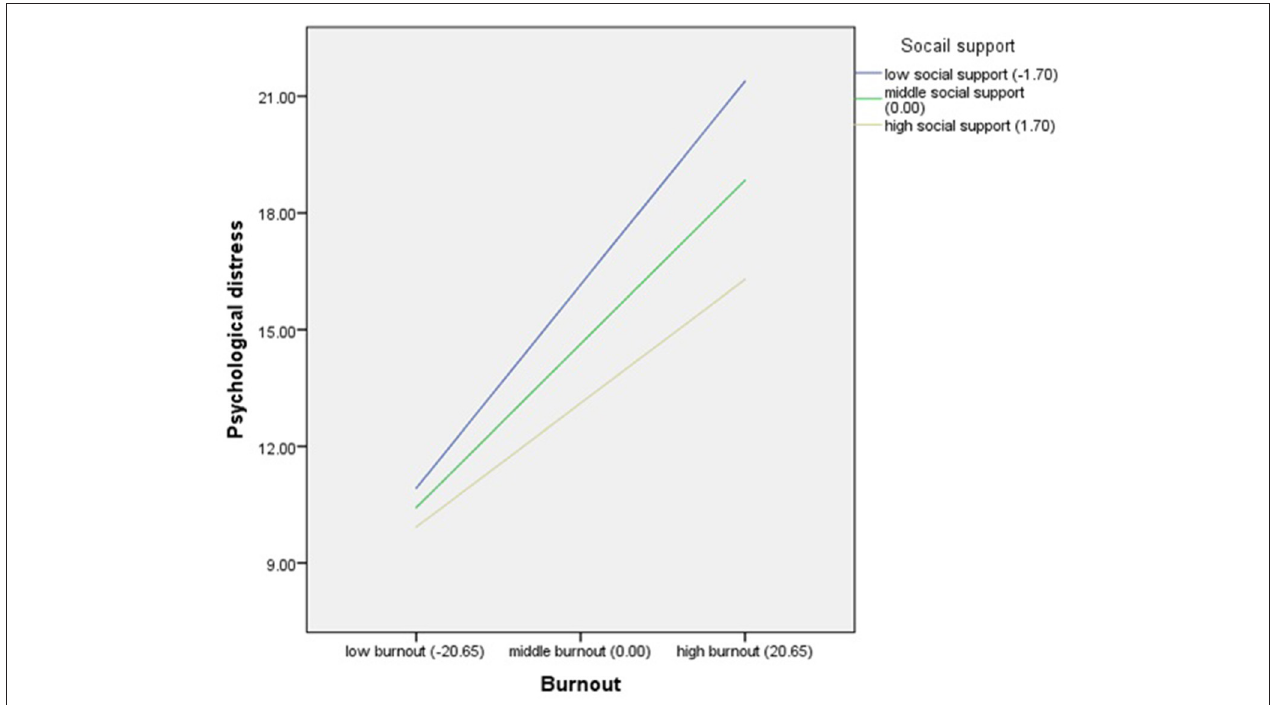
FIGURE 3 | Social support as a moderator between burnout and psychological